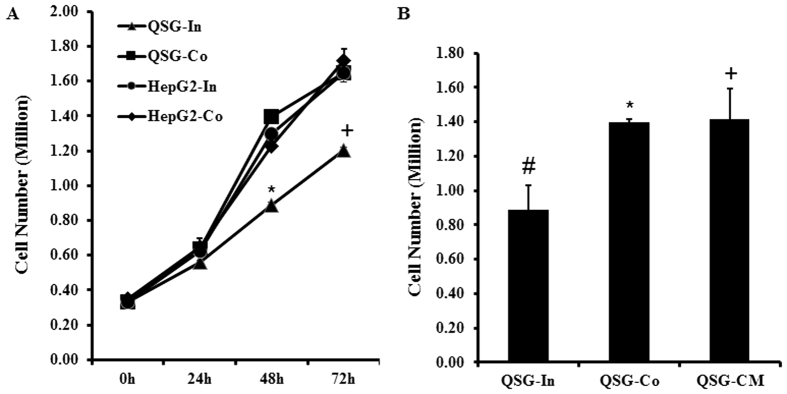
Co-culture with HepG2 increases QSG-7701 cell proliferation.(A) HepG2 and QSG-7701 were cultured individually (In) or co-cultured (Co), the number of viable cells of HepG2 or QSG-7701 at 24 h, 48 h and 72 h after seeding is counted by hemacytometer using 0.4% Trypan Blue Solution (QSG-In vs HepG2-In, or QSG-In vs QSG-Co, p < 0.05 at 48 h* and 72 h+). (B) QSG-7701 cells were cultured individually (In), co-cultured (Co) with HepG2, or cultured with the conditional medium (CM) from HepG2 for 48 h, then the number of viable cells of QSG-7701 was counted by Trypan Blue (#vs*, p < 0.05; #vs+, p < 0.05; *vs+, p > 0.05).